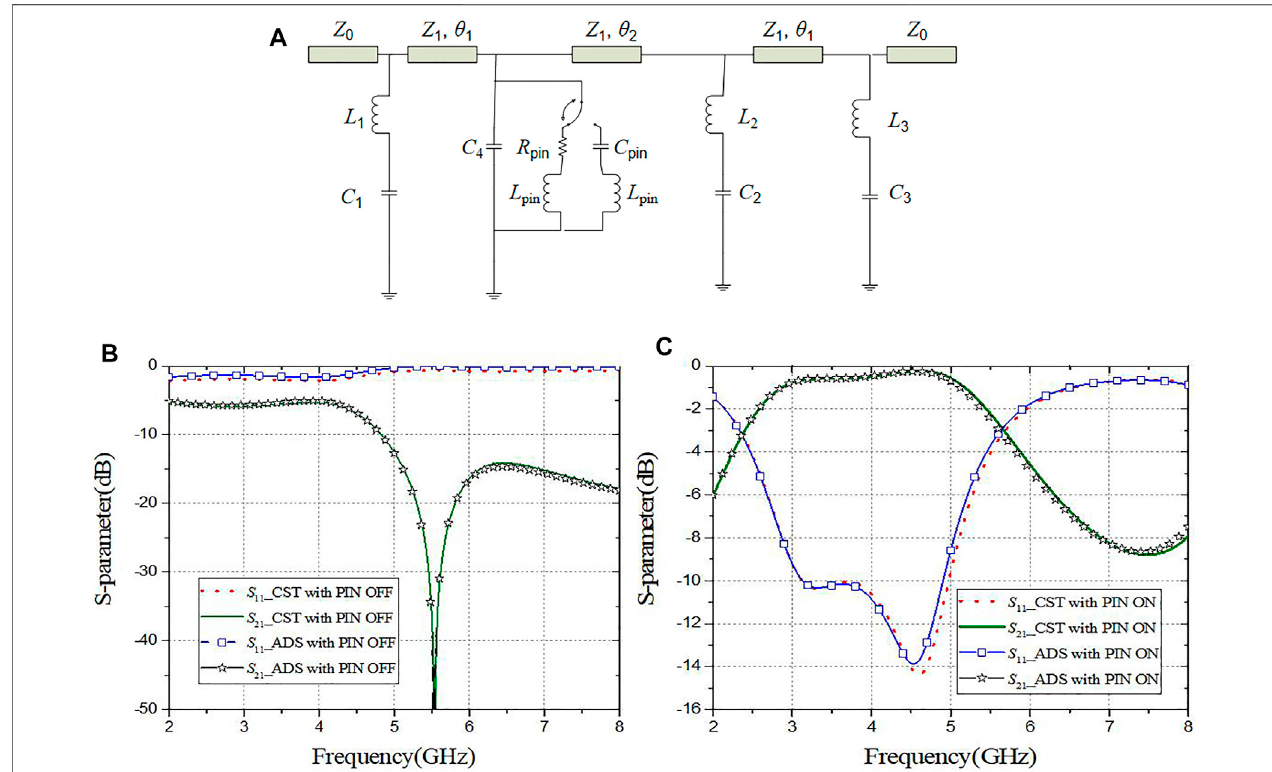
FIGURE8|(A) EquivalentcircuitofthelosslessFSS. (B) S-parameterofCSTandADSwithPINdiodesOFF. (C) S-parameterofCSTandADSwithPINdiodesON.